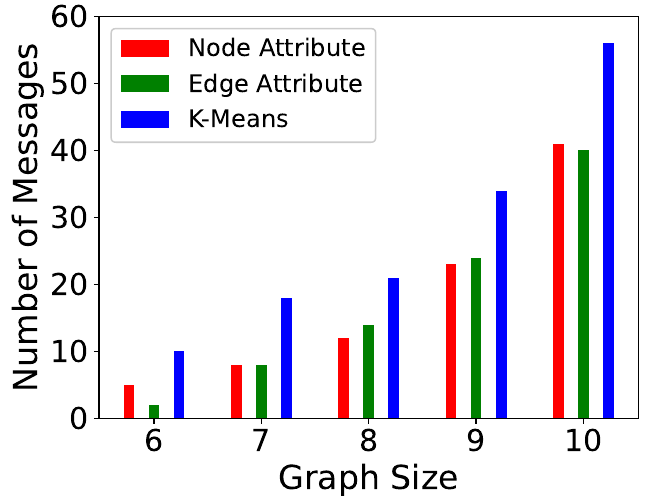
Figure 9. Messages sent for Pg-TSP.